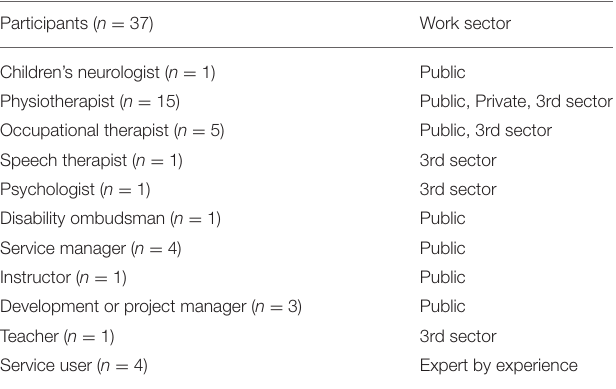
TABLE 1 | Participants in the group